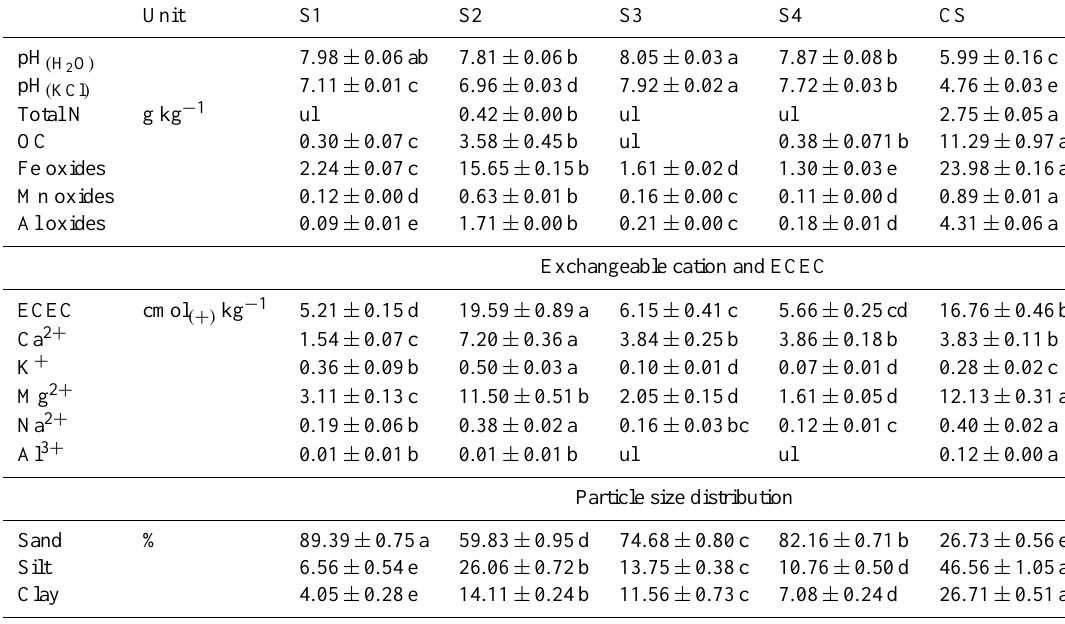
Table 2. Some physicochemical characteristics of the soils (mean values and standard